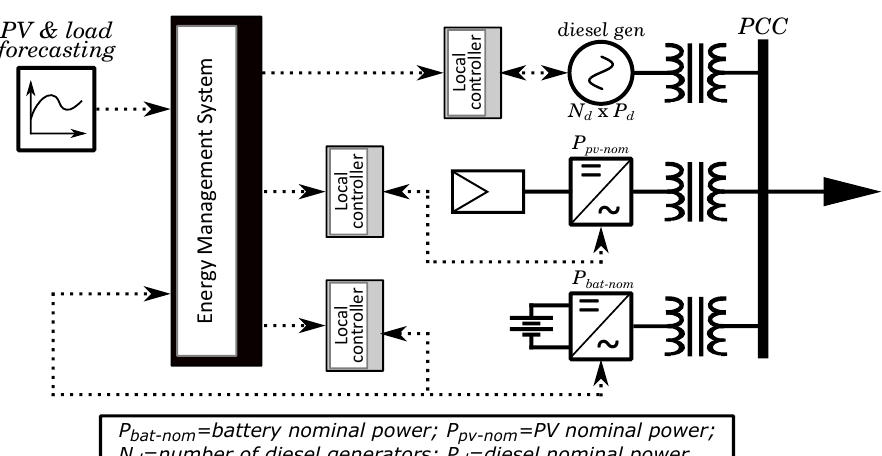
Figure 1. Simplified PV–battery–diesel-based microgrid scheme.